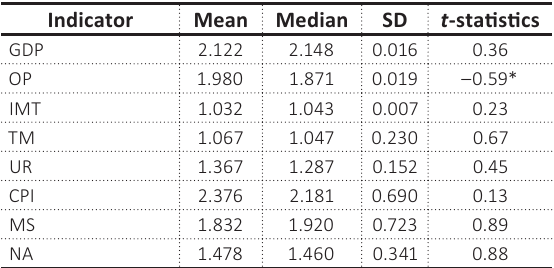
Table 2. Results of mean, median, and